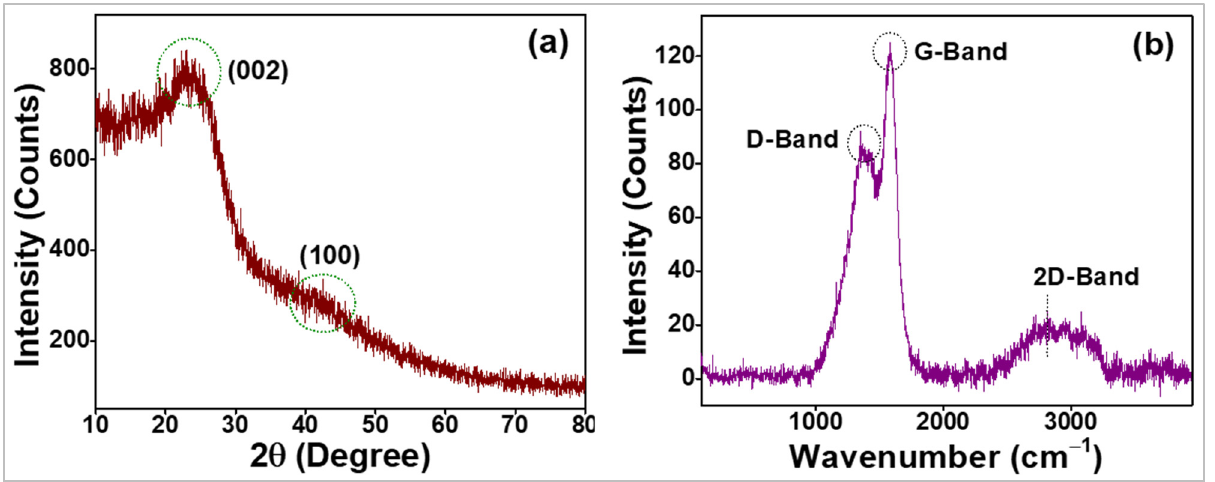
Figure 3. ( a ) XRD pattern and ( b ) Raman spectrum of prepared natural nitrogen-doped carbon